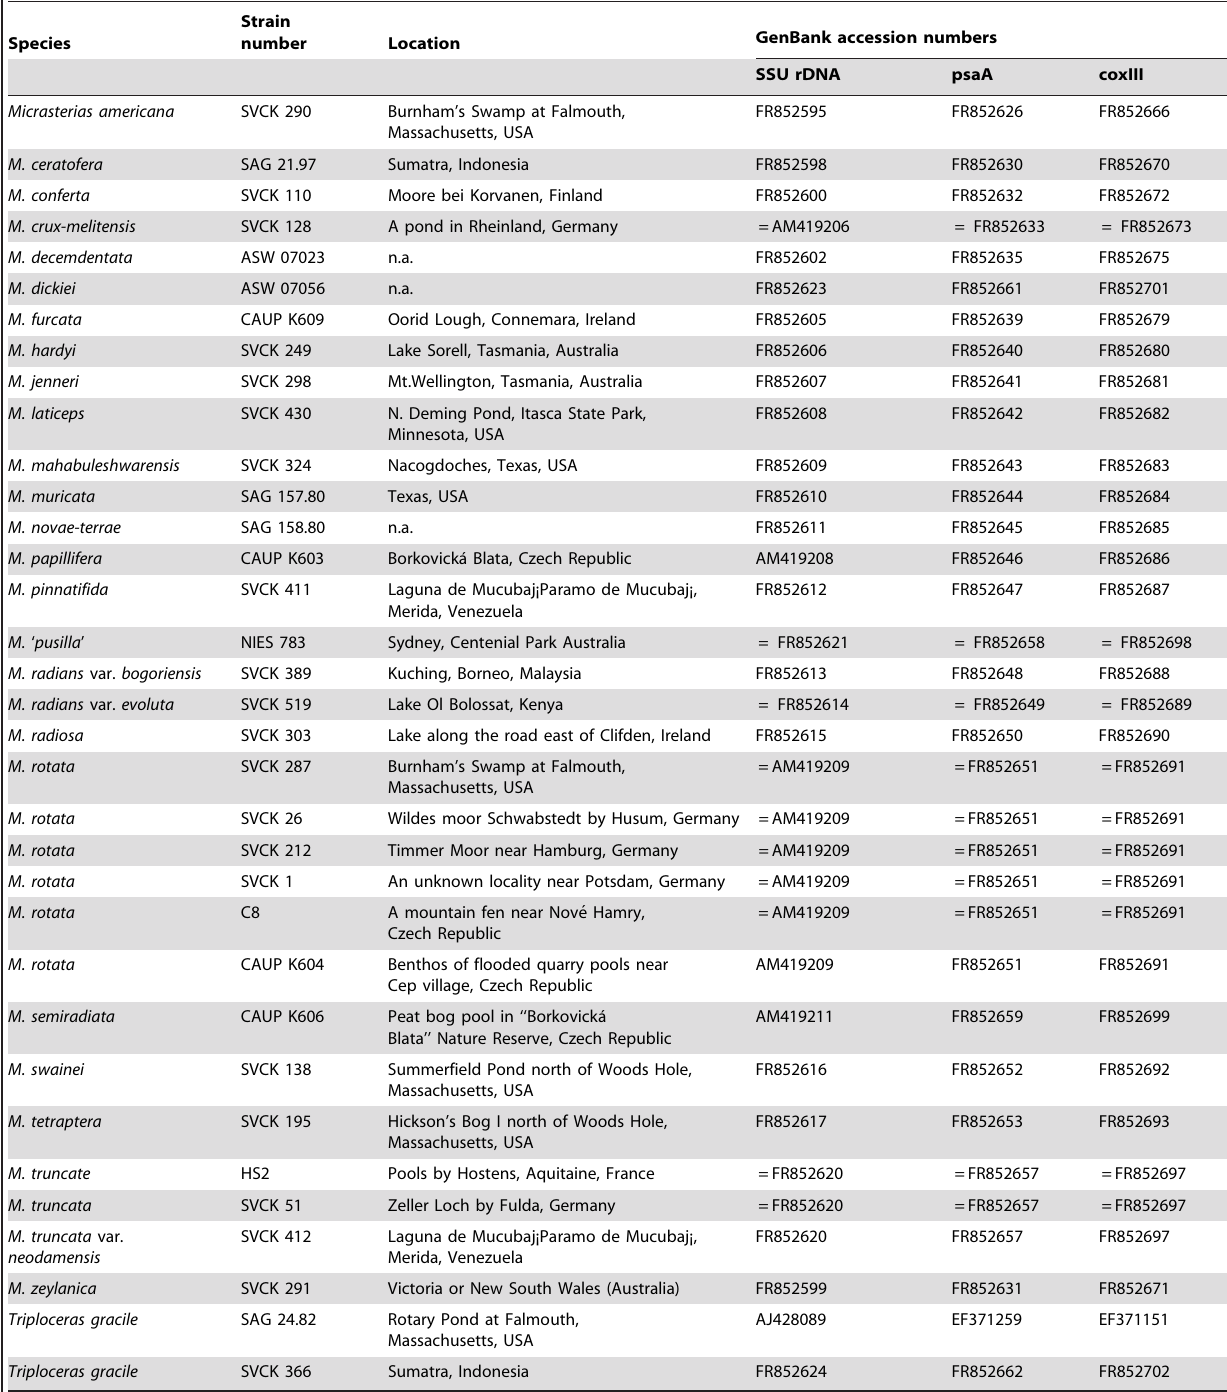
Table 1. List of the strains used in this study with GenBank accession numbers.